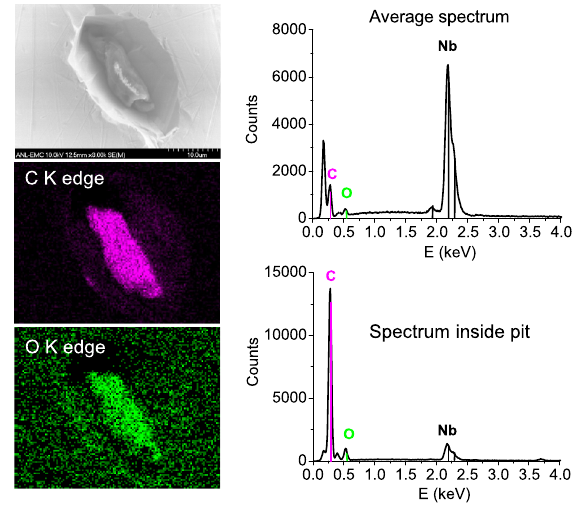
FIG. 8. Left: SEM image and EDX mapping of carbon and oxygen content of a pit on Jlab #12. Right: An average EDX spectrum of the whole area (top) and a spectrum taken inside the pit